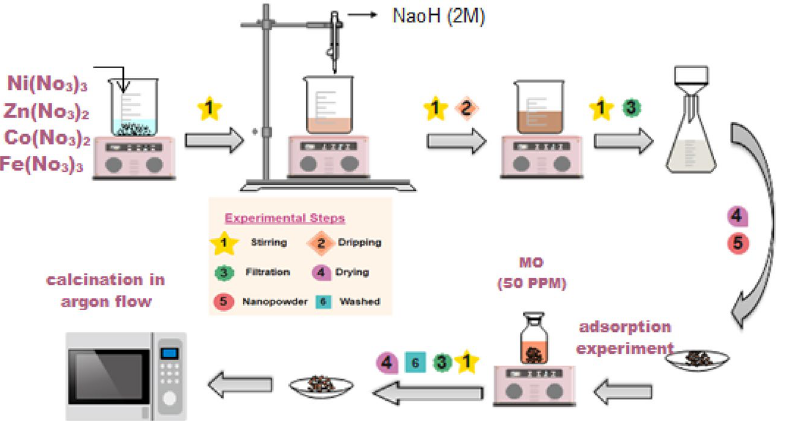
Figure 1. Preparation of Co–Ni–Zn–Fe LDH and Co–Ni–Zn–Fe